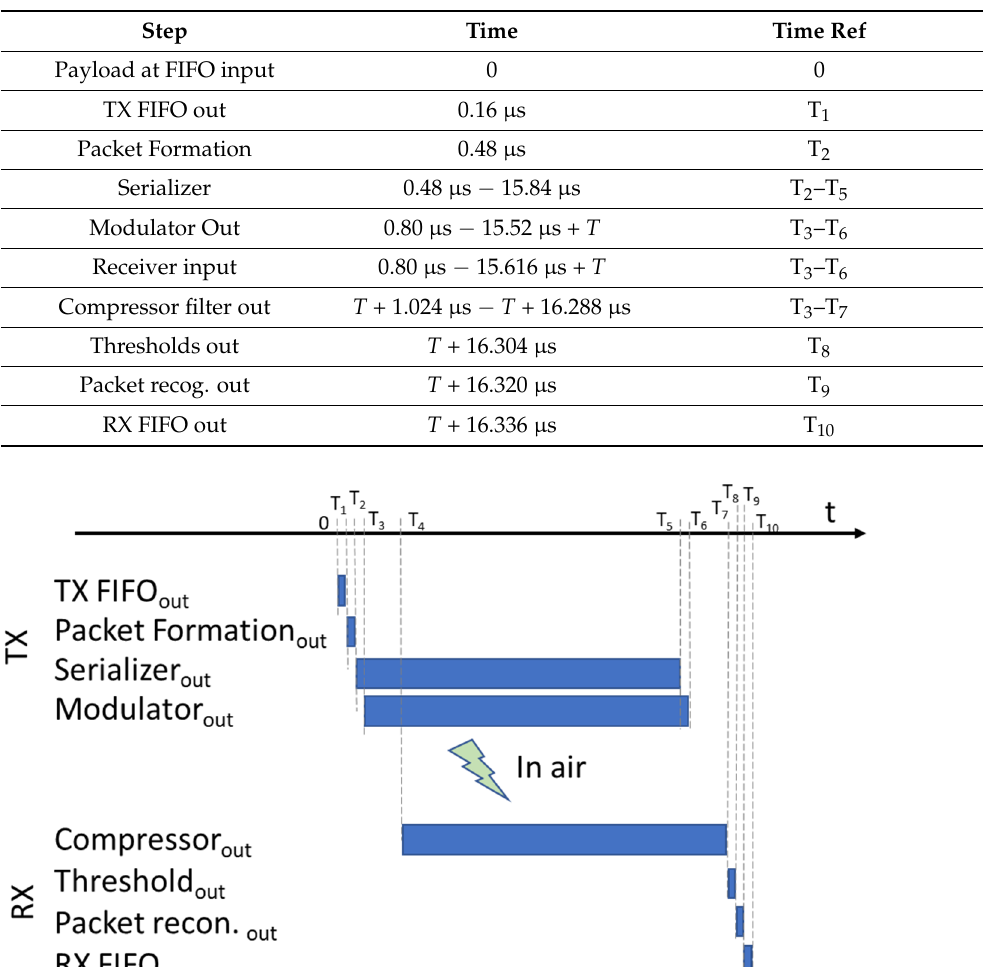
Table 4. FPGA delays in TX-RX data path.